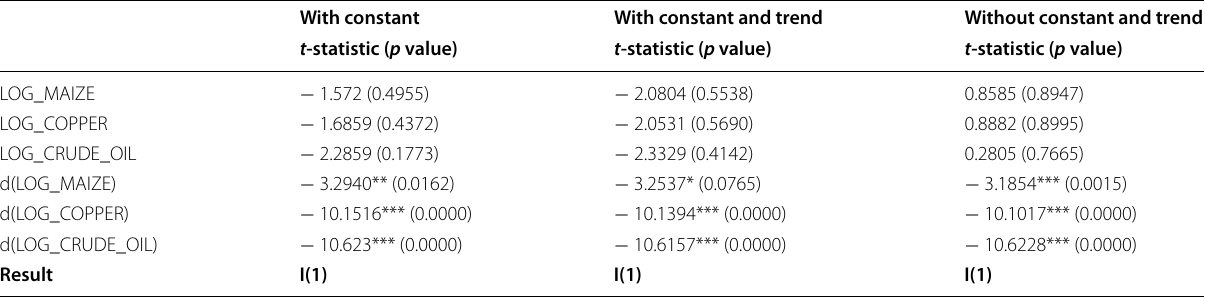
(***, **, *) Significant at 1%, 5% and 10% level, respectively. If t value is without *not significant, b: lag length based on AIC, probability based on MacKinnon [25] one- sided p values. I(1) integrated of order